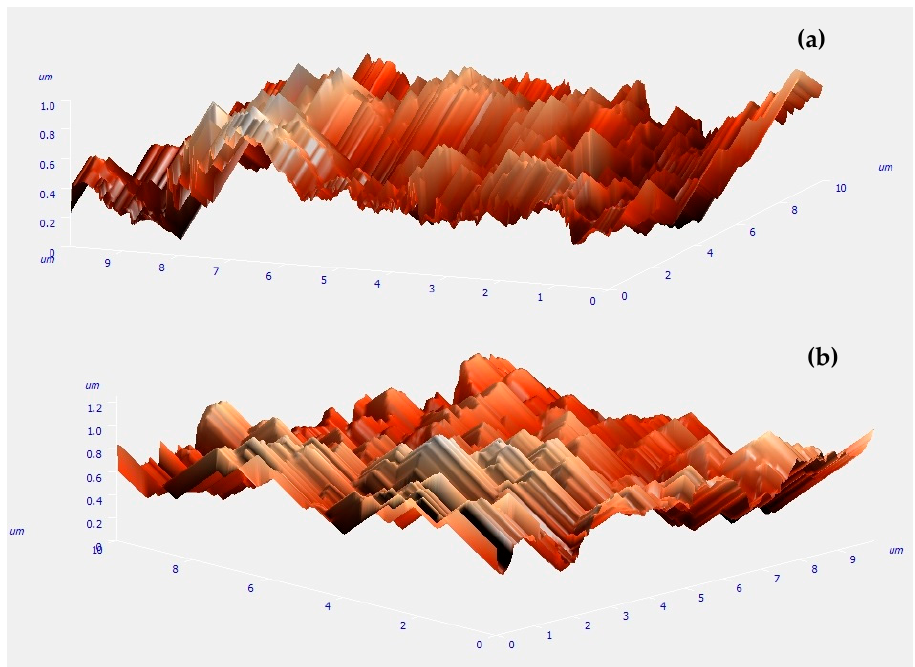
Figure 6. AFM analysis of sample obtained by one-step method ( a ) A for 20 min at 20 mA/cm 2 and ( b ) B for 40 s at 350 mA/cm 2 .